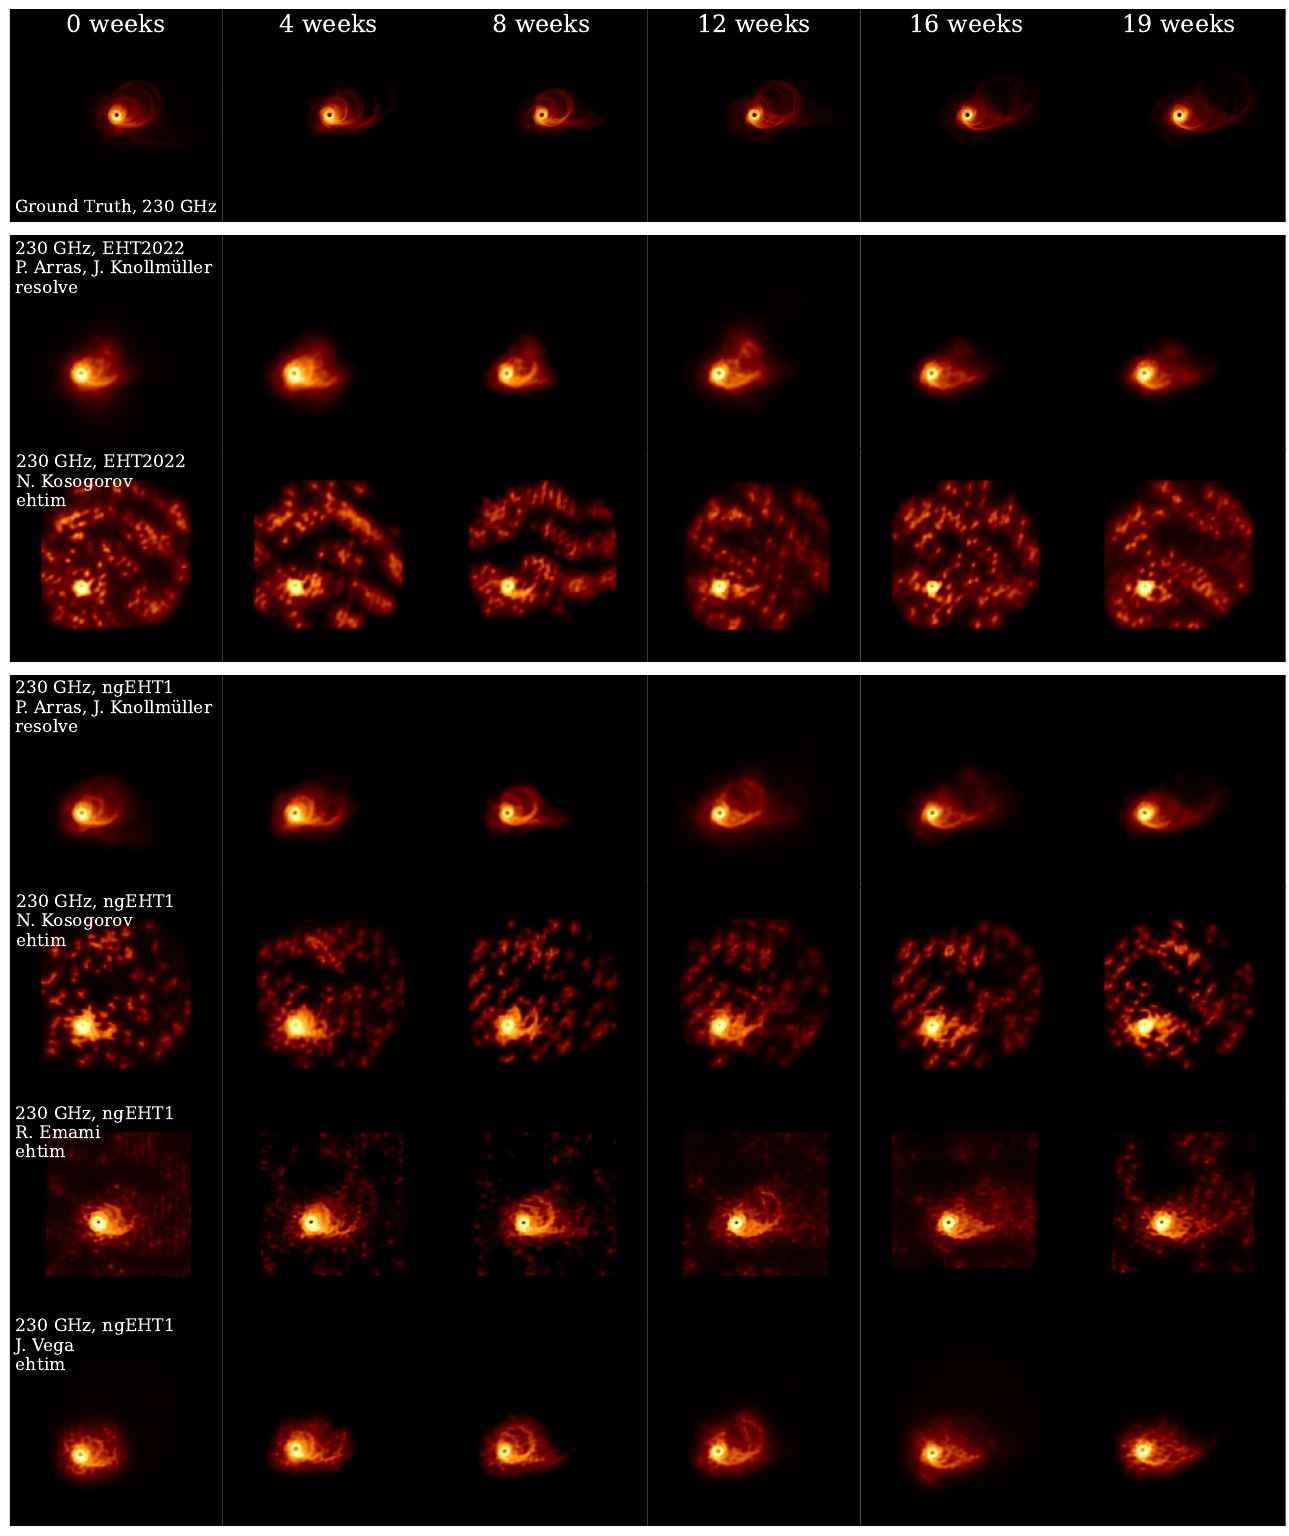
Figure 9. Selection of Challenge 2 M87 230 GHz submissions. Images are shown on a log scale, which is normalized to the brightest pixel value across each submitted set of movie frames, with a dynamic range of 10 3.5 , on a field of view of 1